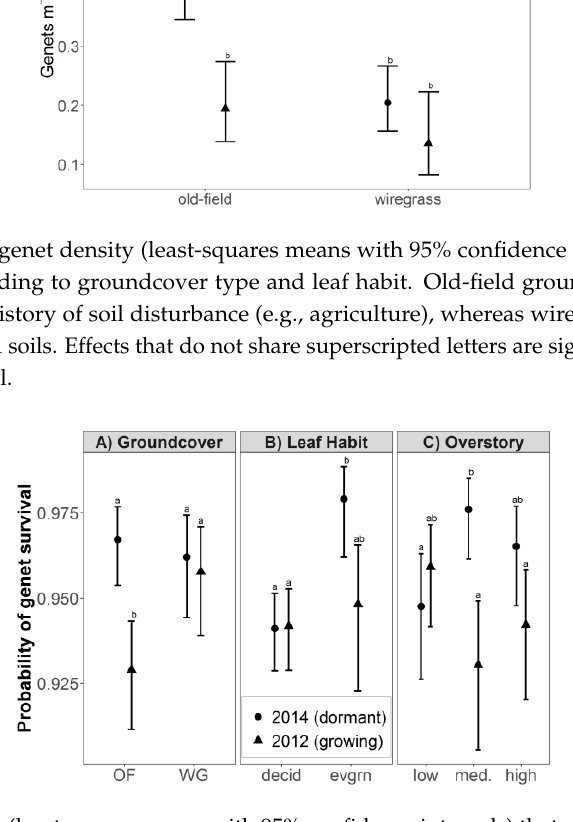
Figure 2. Probabilities (least-square means with 95% confidence intervals) that understory hardwood genets will survive biennial prescribed fire in longleaf pine woodland in SW Georgia, USA ( A ) Interactive effects of fire-season and groundcover composition; ( B ) Fire-season and leaf habit; ( C ) Fire- season and overstory density. Within each panel, effects that do not share superscripted letters are significantly different at a 95% confidence level. Abbreviations: old-field, OF; wiregrass, WG; deciduous, decid.; evergreen, evgrn; medium,